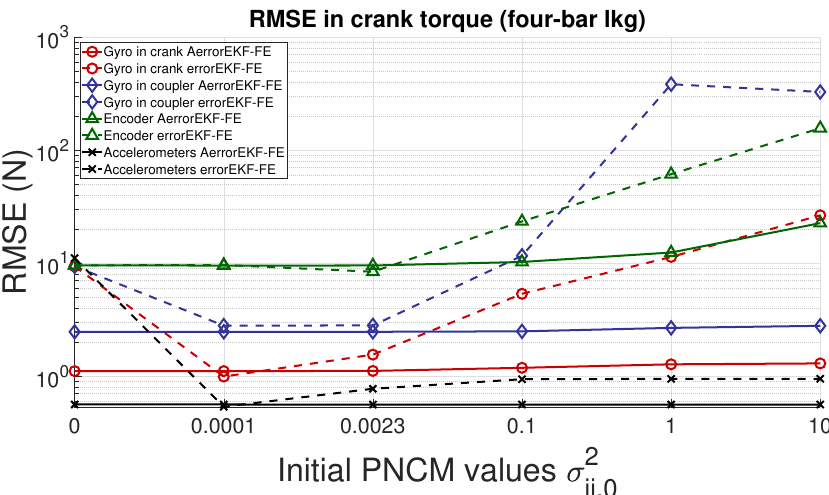
Figure 9. RMSE in the forces acting on the crank provided by the observers for the four-bar